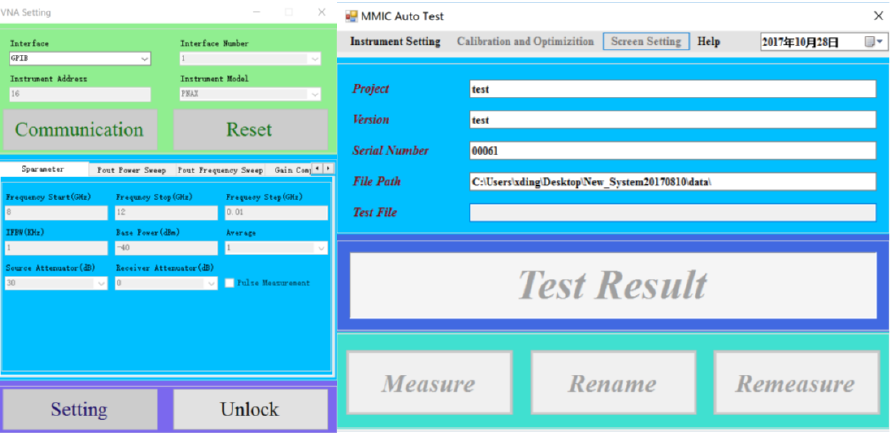
Figure 16. The whole system setup.